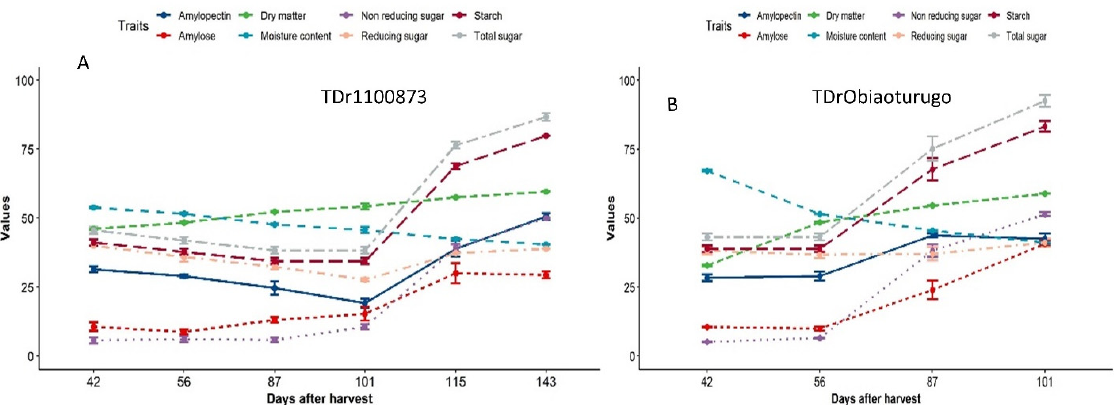
Figure 2. ( A , B ) Metabolic changes in non-structural sugar, dry matter, and moisture content in two white yam genotypes’ tubers from dormancy to sprouting. ( A ) The data for TDr1100873 and ( B ) the data for Obiaoturugo . Error bars indicate statistically significant differences among the variables at p ≤ 0.05. The six sugar parameters, dry matter, and moisture content are shown with colored lines, their values are on y -axis (multiple parameters with different units are shown on the same axis; hence, no unit was attached to the values). Total sugar, starch, reducing and non-reducing sugars, amylose, and amylopectin were all measured in mg/100 mg as units, whereas dry matter and moisture were measured in percentage as units. The values on x -axis are days after tuber physiological